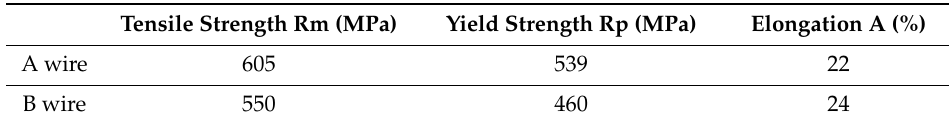
Table 2. Mechanical properties of the weld metal made with the use of wires according to the manufacturer’s